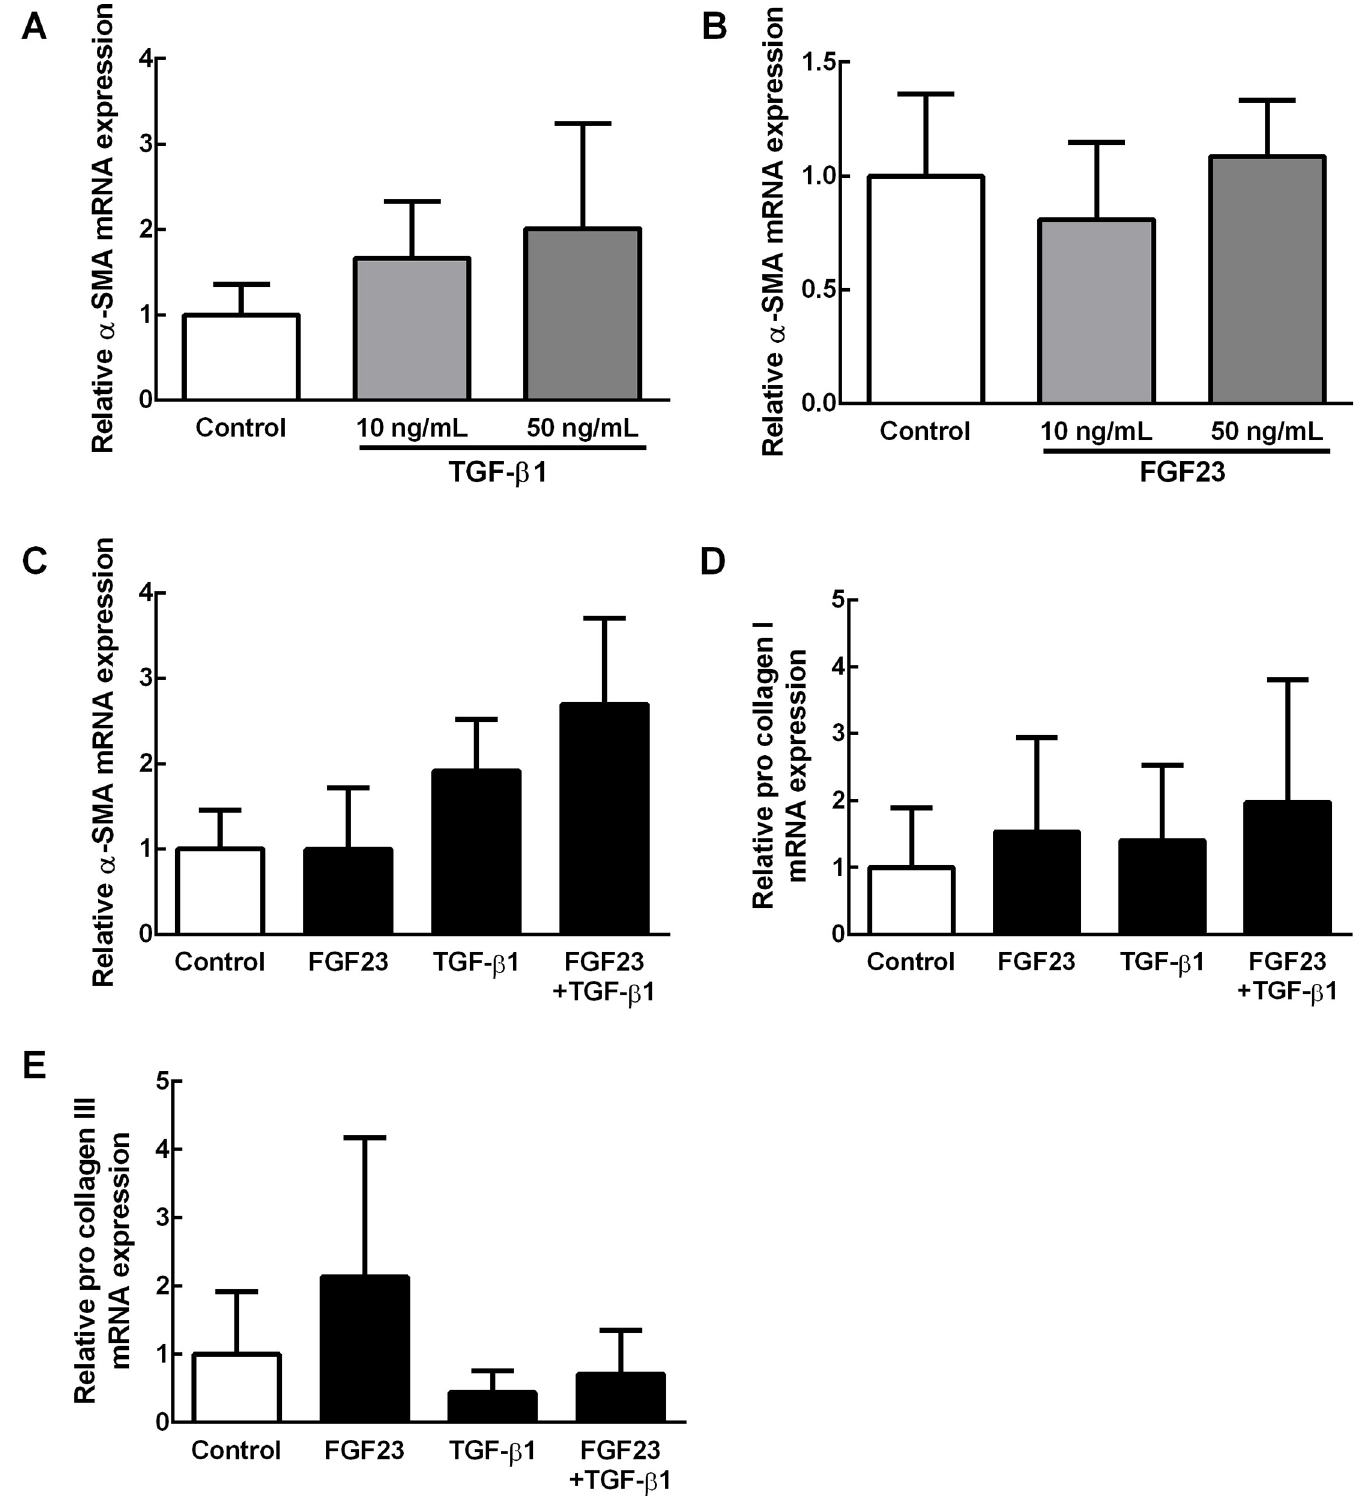
Fig 3. mRNA expression levels in fibroblasts as measured by RT-PCR. (A) α -SMA expression levels after treatment with TGF- β 1 (n = 6). (B) α -SMA expression levels after treatment with FGF23 (n = 6). (C) α -SMA expression levels after treatment with combination of FGF23 and TGF- β 1 (n = 5). (D) pro collagen I expression levels after treatment with a combination of FGF23 and TGF- β 1 (n = 5). (E) pro collagen III expression levels after treatment with a combination of FGF23 and TGF- β 1 (n = 5), Values are means ± SEM.